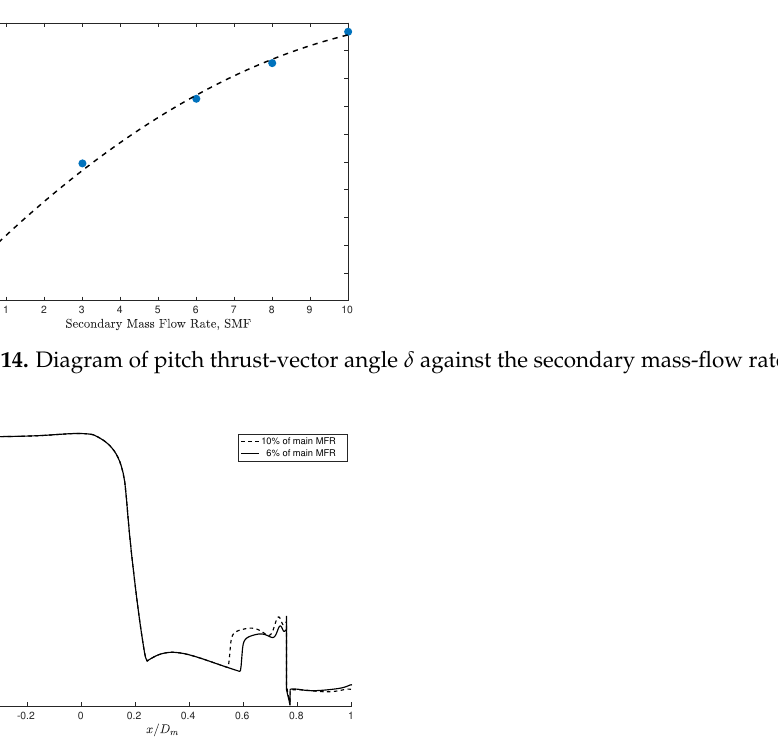
nonlinear increase in the value of δ , up to about 4.5 ◦ for SMF = 10%, following an almost 3.5% to about 7.5% of the axial force component, F x . At the same time, the axial force